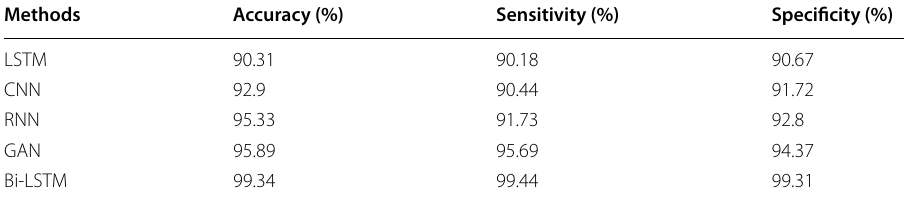
Table 4 Performance analysis of different deep learning methods for classification on UCM dataset Methods